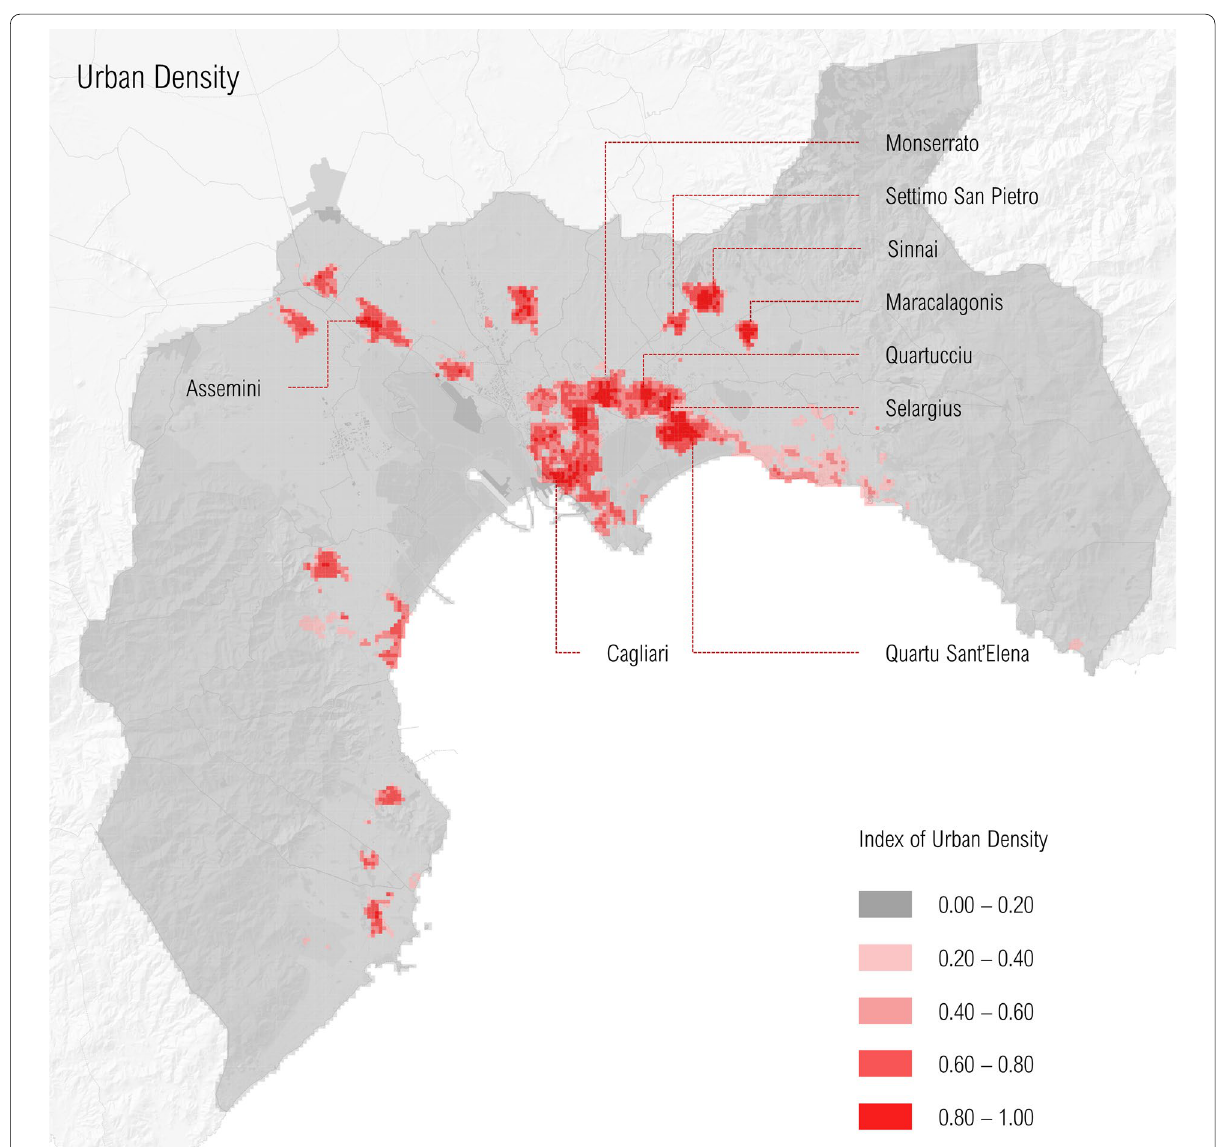
Fig. 11 Distribution of the values of the Index of Urban Density (I_UD) across the Metropolitan City of